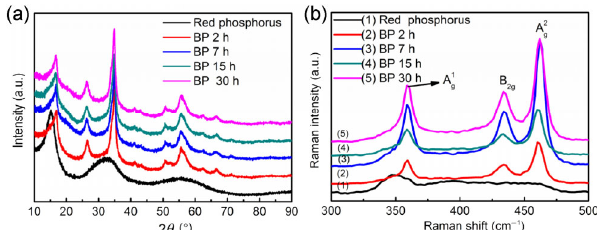
Fig. 4 SEM images of the BP powders at ball-milling for 30 h.